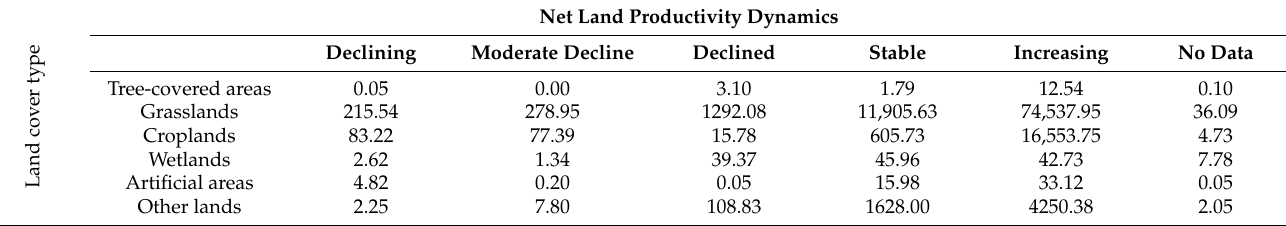
Table 4. Trends in land productivity or functioning (for pixels with unchanged land cover) (km 2